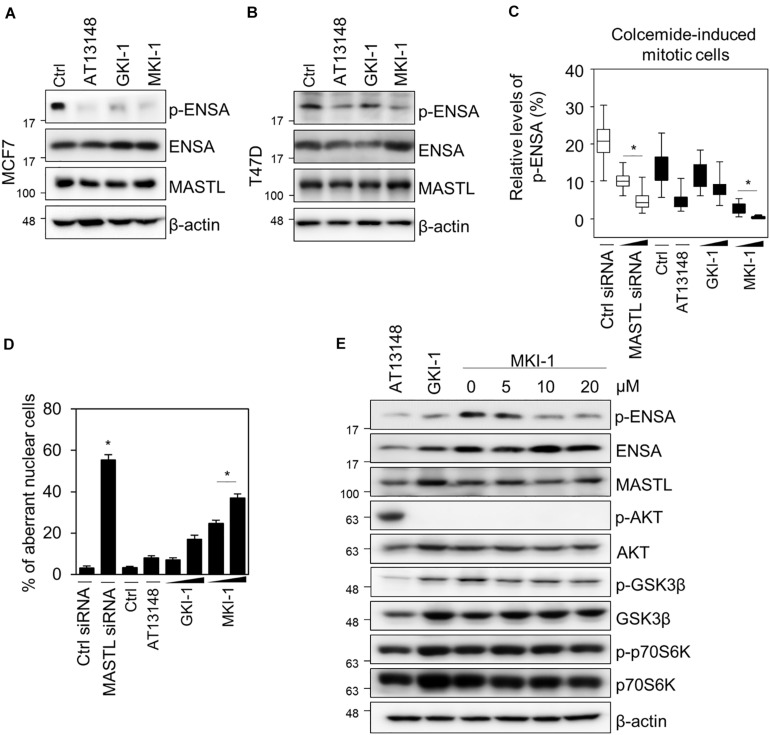
MKI-1 inhibits the activity of MASTL in breast cancer cells. (A,B) MCF7 and T47D cells were treated with DMSO (Ctrl), 5 μM AT13148, 15 μM GKI-1, and 15 μM MKI-1 for 20 h. The cell lysates were analyzed by immunoblotting with the indicated antibodies; β-actin was used as the loading control. (C,D) MCF7 cells transfected with either control siRNA or MASTL siRNA (20 or 40 nM) for 24 h were arrested in mitosis using colcemide (80 ng/mL) for 16 h or MCF7 cells with colcemide were treated with Ctrl (DMSO), 5 μM AT13148, GKI-1 (15 or 30 μM), and MKI-1 (15 or 30 μM) for 16 h. Immunofluorescence staining was performed using anti-phospho(Ser67) ENSA. The intensities of phospho-ENSA or aberrant nuclear cells such as nuclei with irregular shapes or fragmented nuclei were scanned and determined by using the IN Cell Analyzer HCA System. At least 17 images, each image contains more than 100 cells, were analyzed from each group by IN-Cell analyzer. (E) MCF7 cells were treated with 5 μM AT13148 for 24 h, 15 μM GKI-1 for 24 h, and MKI-1 (at the indicated doses) for 24 h. Cell lysates were analyzed by immunoblotting with the indicated antibodies; β-actin was used as the loading control. The data represent typical results and are presented as the mean ± standard deviation of three independent experiments. *P < 0.01.